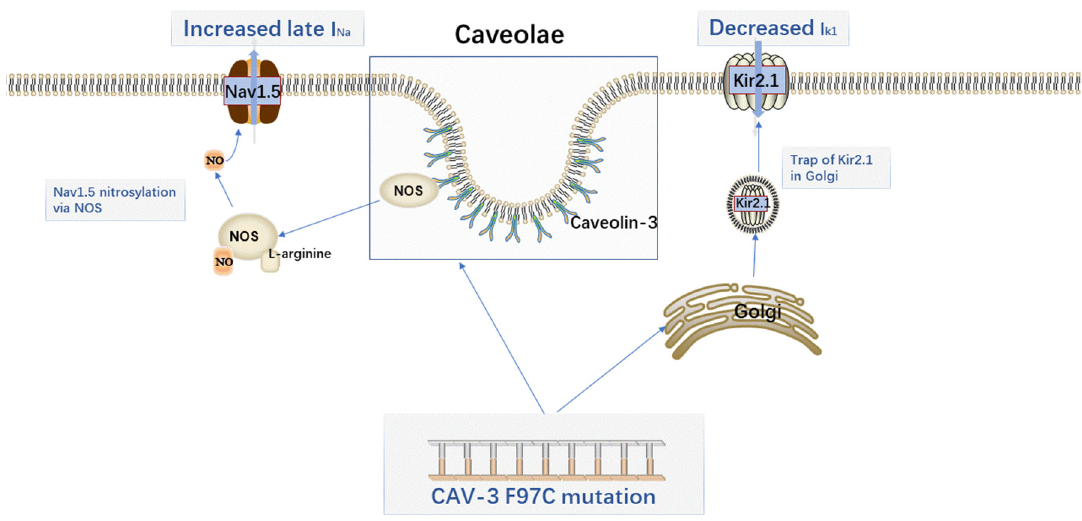
Figure 1. Cartoon illustration of arrhythmia mechanism caused by Cav3 mutation (F97C). NOS, Nitric oxide synthase; NO, Nitric oxide.